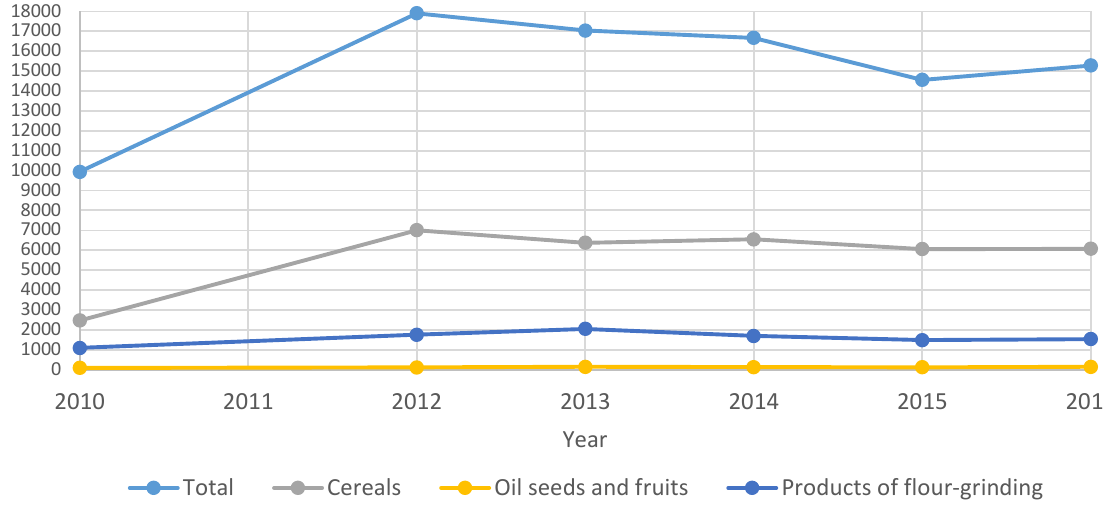
Figure 3. Export of agrarian products of